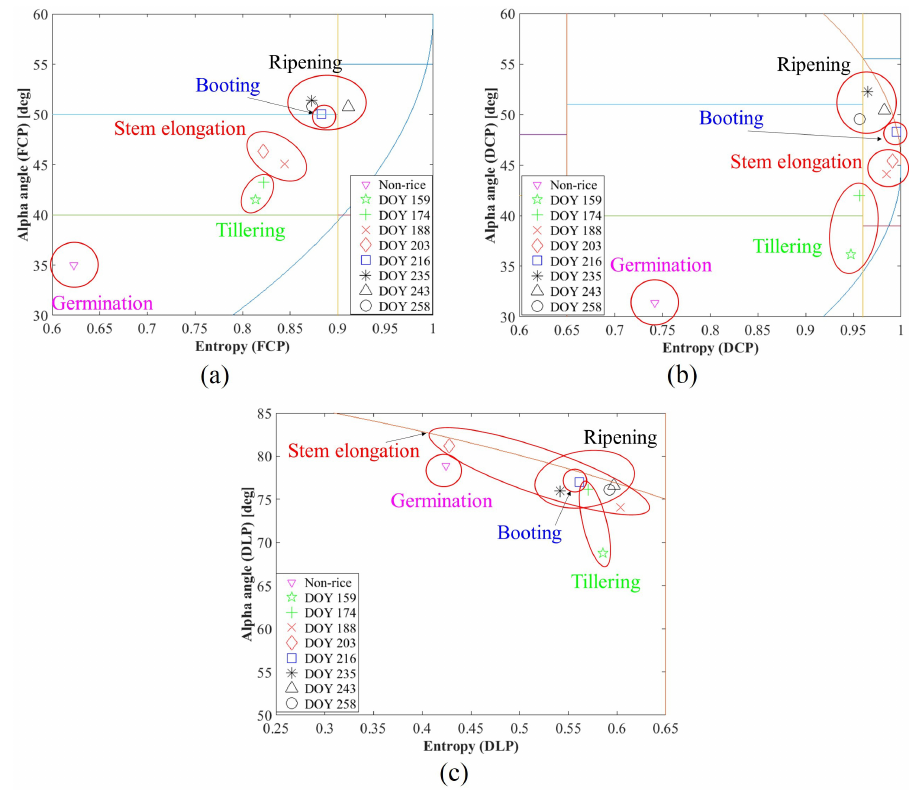
Figure 10. The H /¯ α 2D plane. ( a ) FCP mode; ( b ) DCP mode; ( c ) DLP